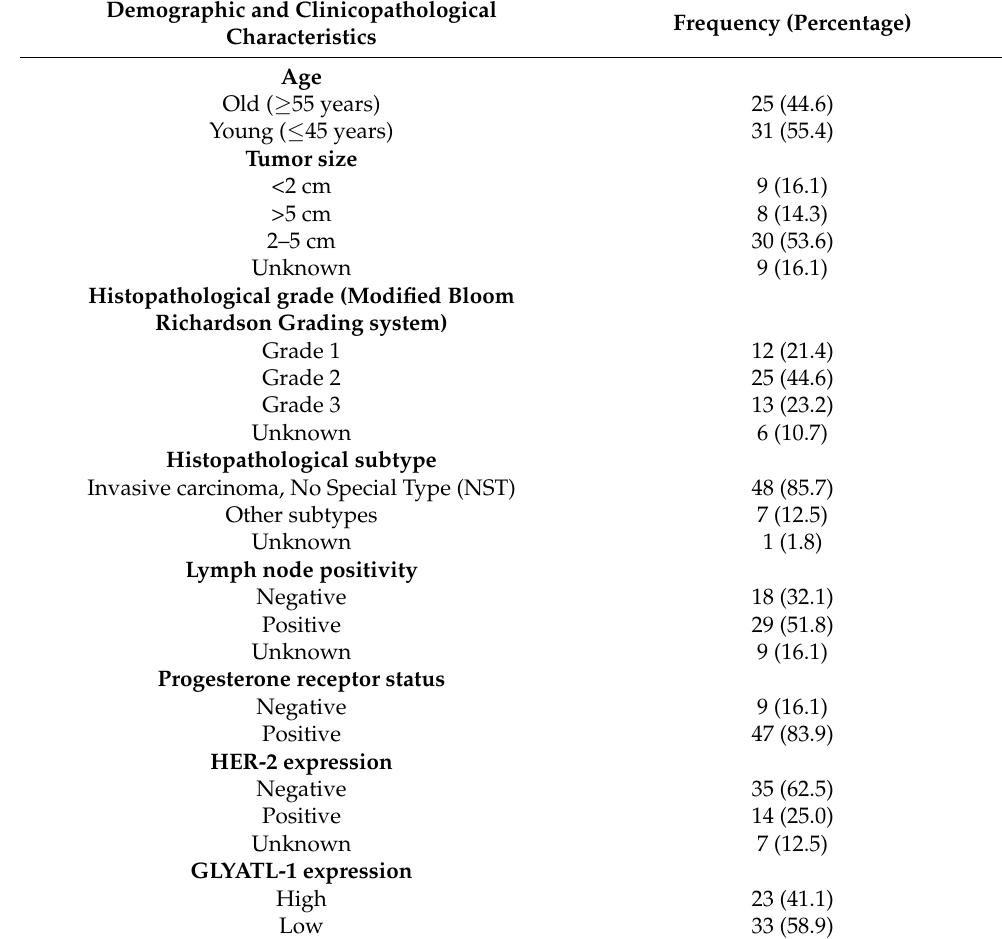
Table 4. Clinicopathological characteristics of 56 breast carcinoma cases stained with GLYATL-1.